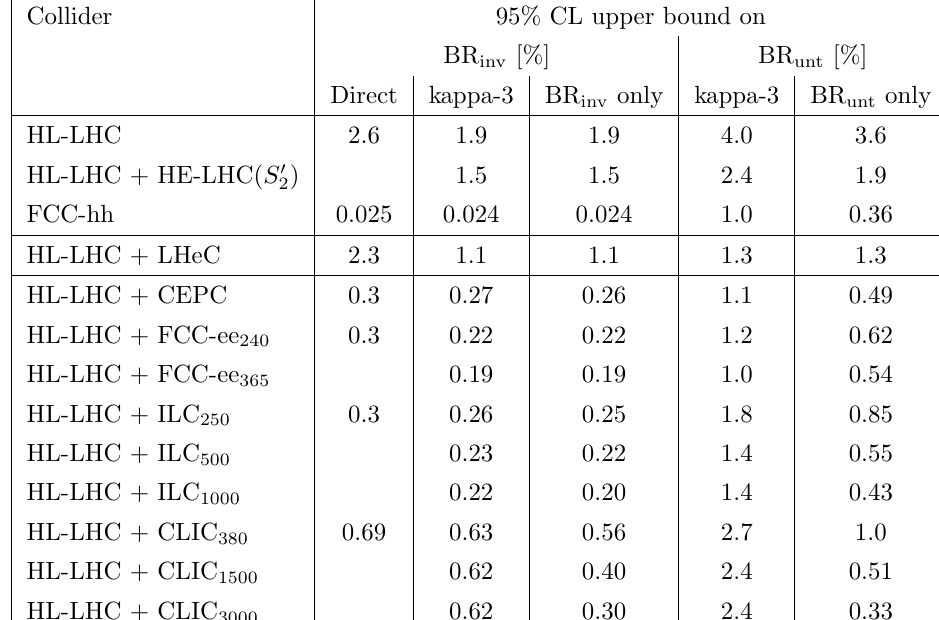
Table 14 . Expected upper limits on the invisible and untagged BRs of the Higgs boson. The SM decay, H ! 4 (cid:23) , has been subtracted as a background. Given are the values of the direct searches using missing (transverse) momentum searches, the constraint derived from the coupling (cid:12)t (see table 5) in the kappa-3 scenario, and the result from a (cid:12)t in the (cid:20) framework where only modi(cid:12)cations of BR inv are allowed. The last two columns show the corresponding information for untagged BR of the Higgs, BR unt . For all (cid:12)ts the direct search for invisible decays is included.